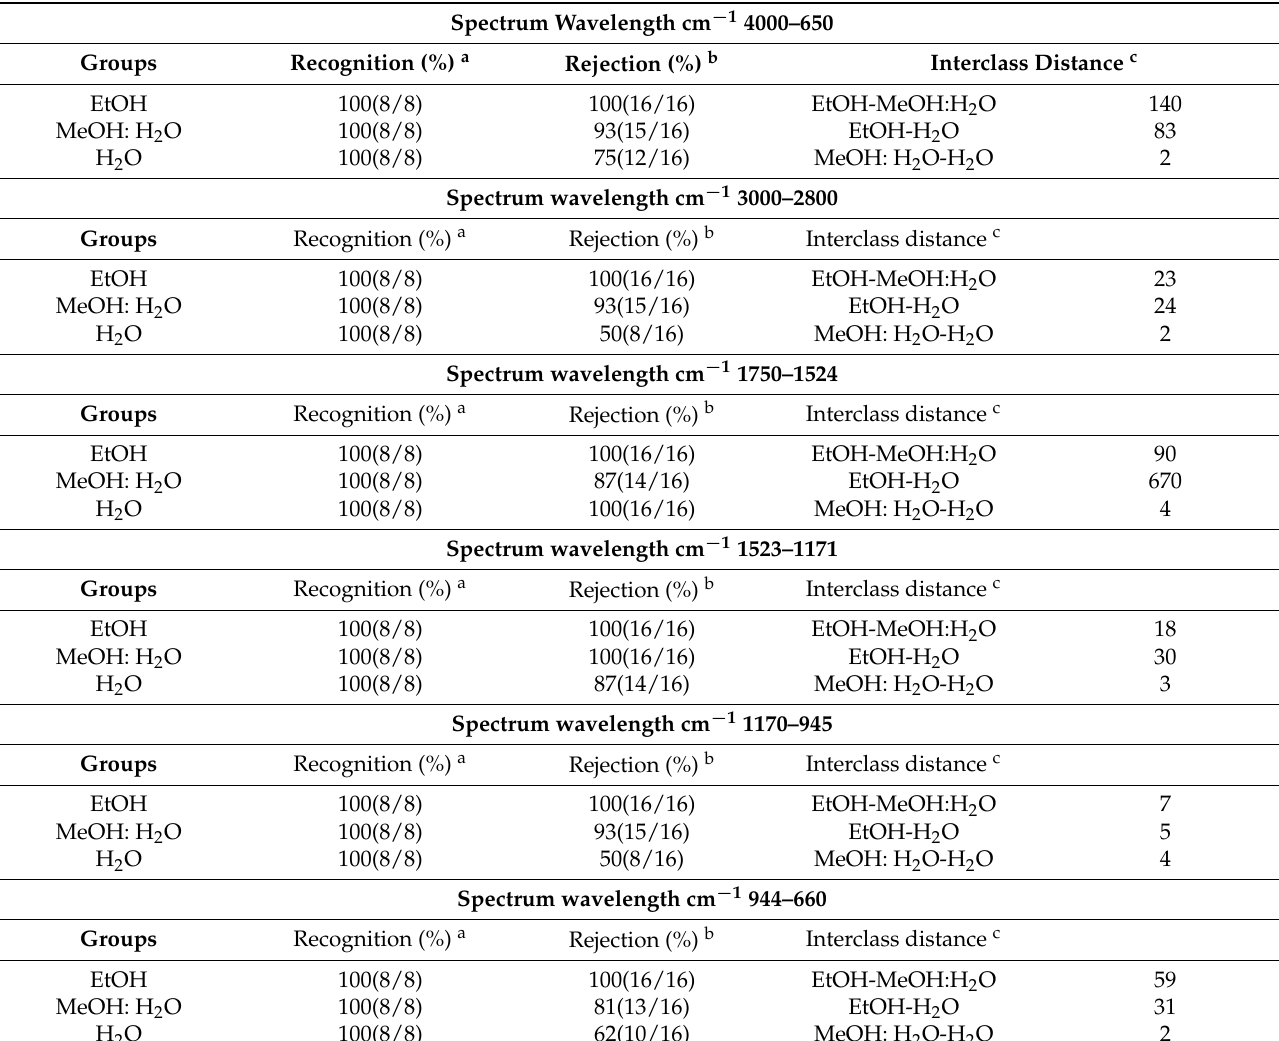
Table 5. Interclass distance of ethanol (EtOH), methanol:water (MeOH:H 2 O) and water (H 2 O) extracts. Spectrum Wavelength cm − 1